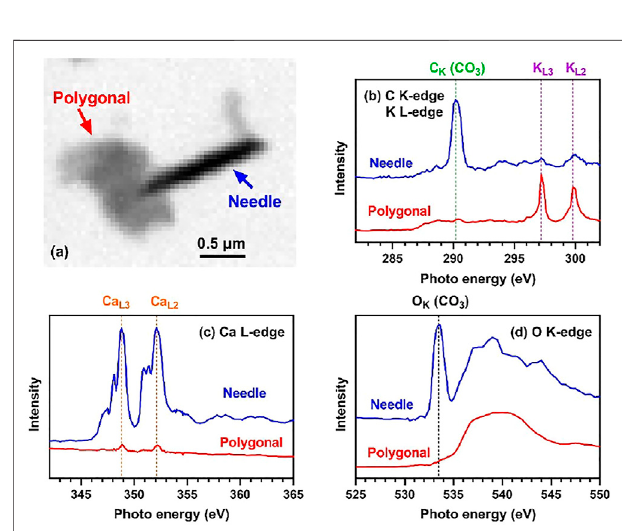
FIGURE 9 | STXM image and X-ray spectra of representative particles. (A) Optical image, (B) spectra scanned at C K-edge and K L-edge, (C) Ca L-edge spectra, (D) O K-edge spectra. Blue lines and red lines represent the mean spectra for needle-like particles and polygonal particles,